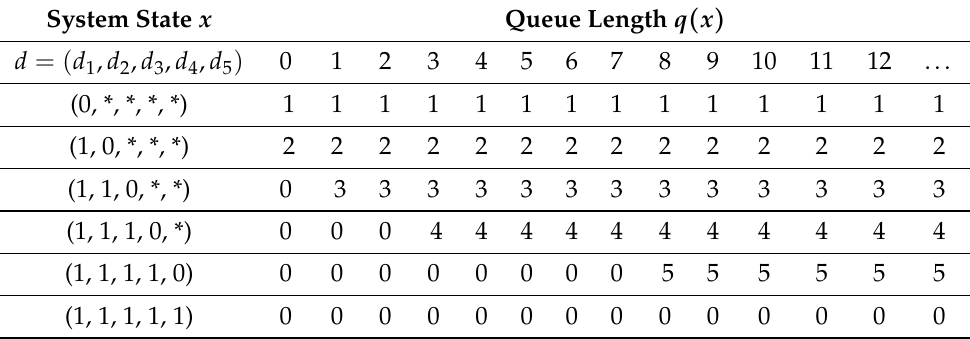
Table 1. The optimal control